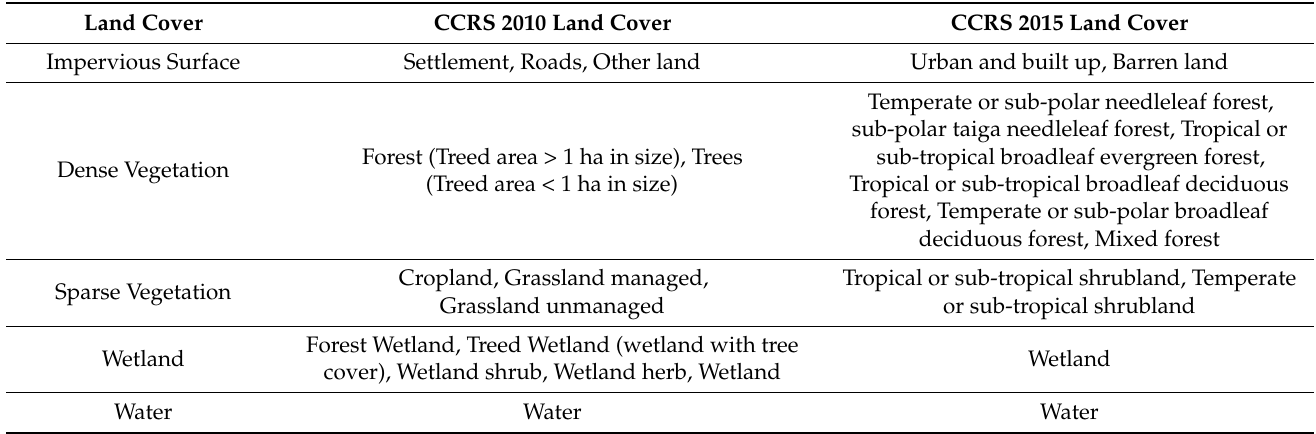
Figure 2. Image Distribution of all images used in the study from 1982 – 2020. Table 1. Land Cover Reference Data 2010 and